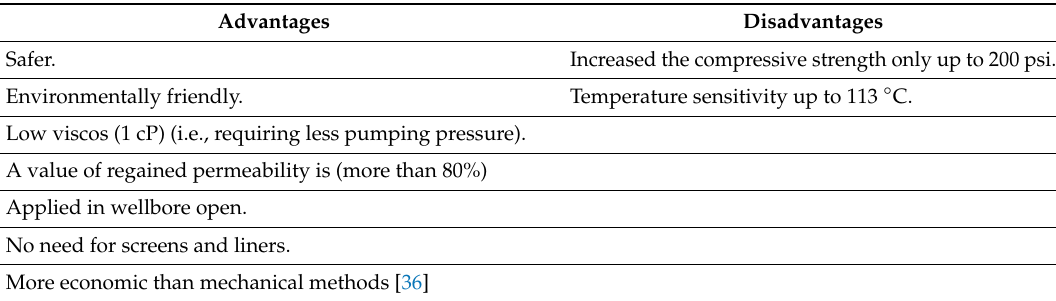
Table 24. Advantages and disadvantages of water-based and saline-based methods.